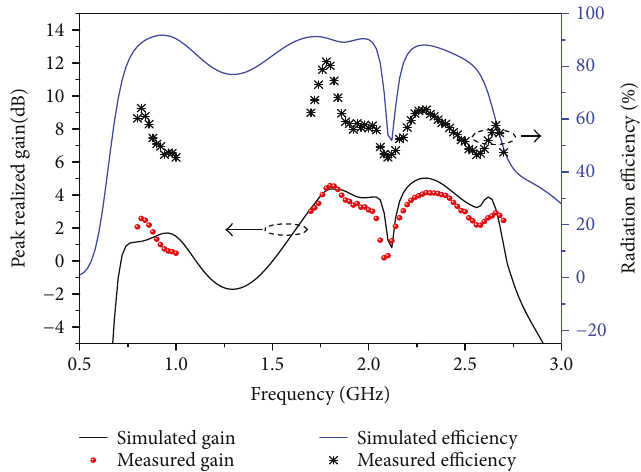
Figure 10: Simulated and measured peak realized gain and e ffi